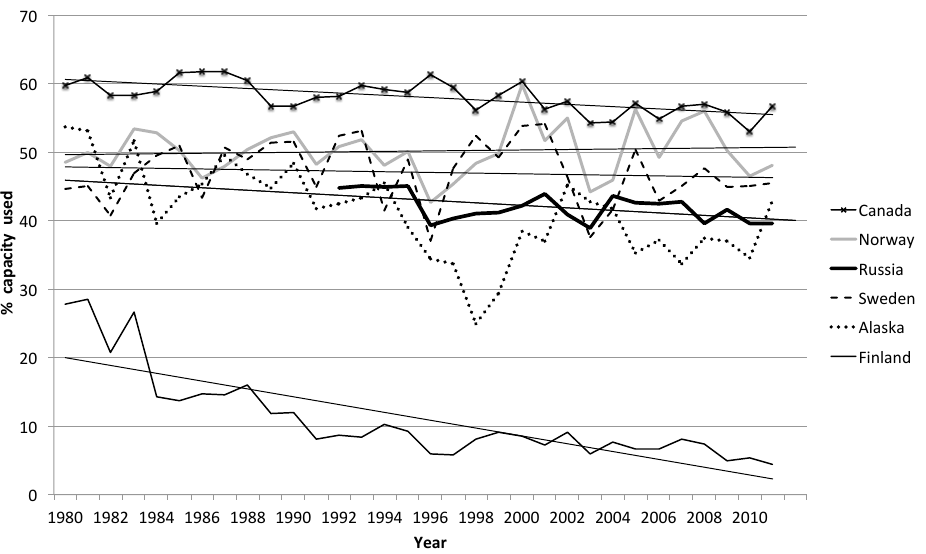
Figure 4. Percent capacity of hydropower used in selected northern regions, 1980–2012. Data are from the Energy Information Administra- tion and the Alaska Energy Data